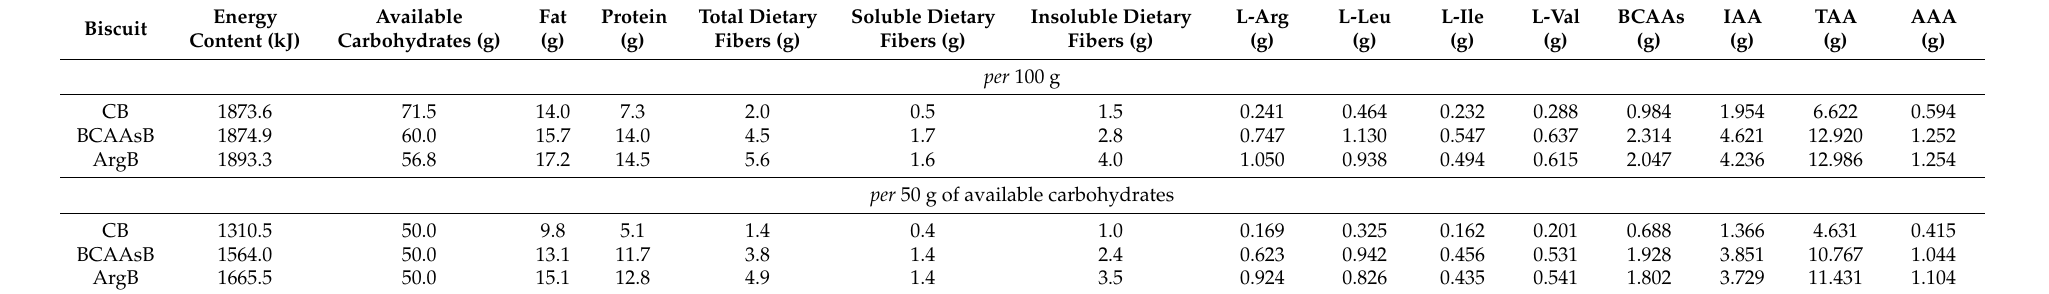
Table 2. Nutritional composition of the three tested